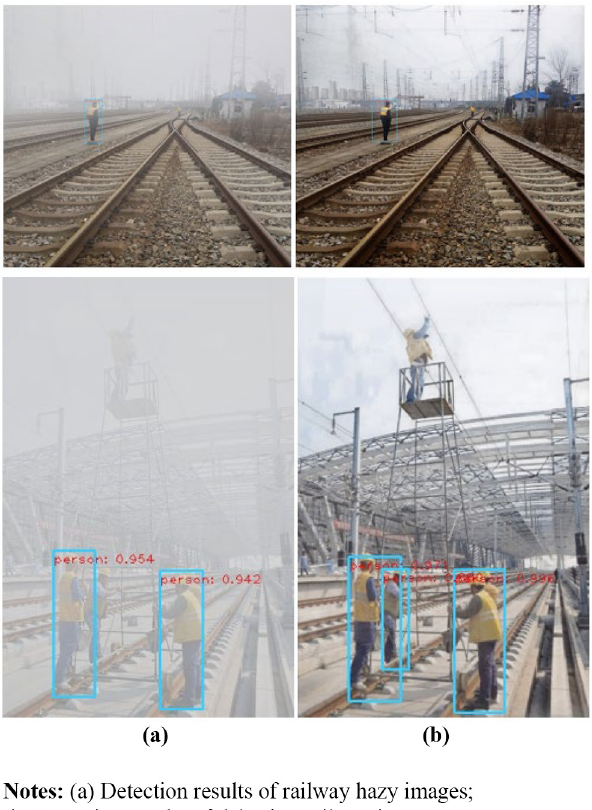
Figure 9. Foreign objects detection results evaluated on railway hazy images and dehazing